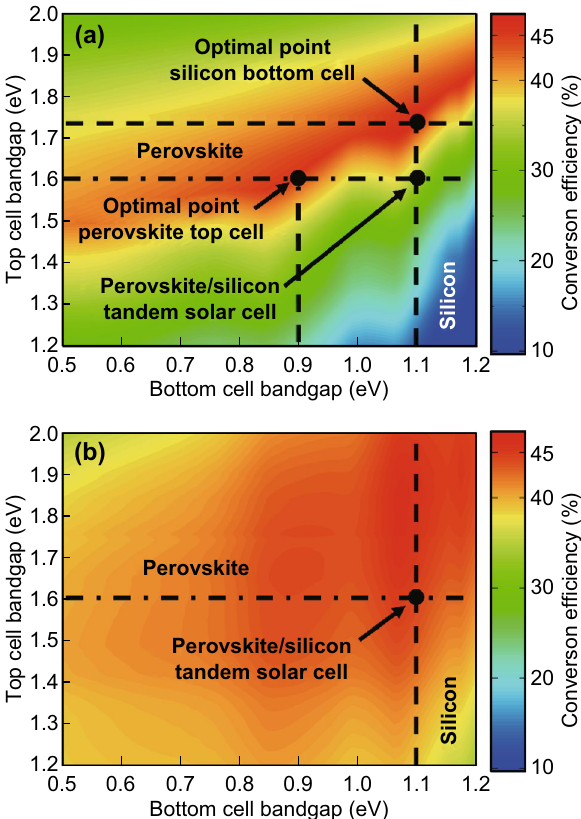
Fig. 8 Detailed balance conversion efficiency limit for a 2-terminal and b 4-terminal tandem solar